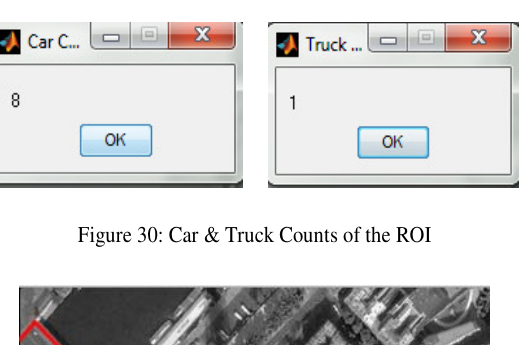
Figure29: Quickbird Greyscale Image (0.61m) & ROI